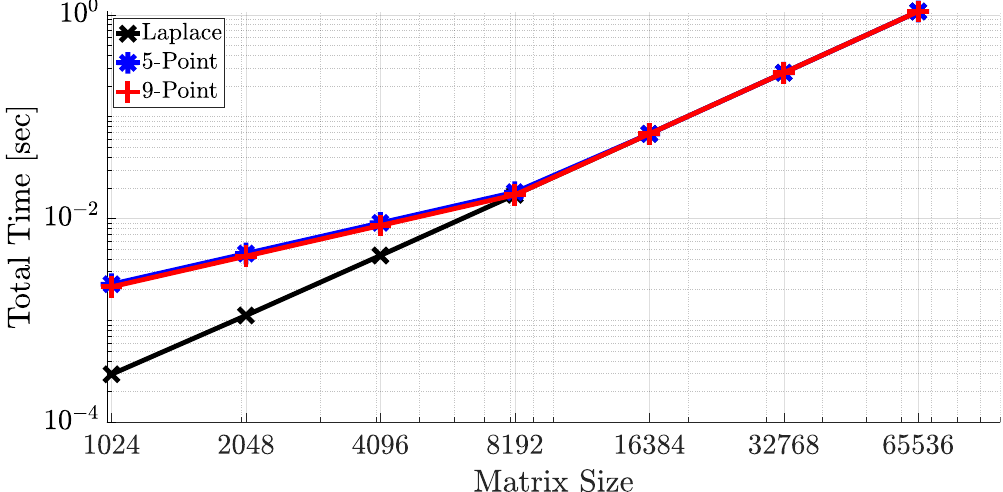
Figure 7. Single iteration run times of three stencil codes with variable array size of nxm where n =